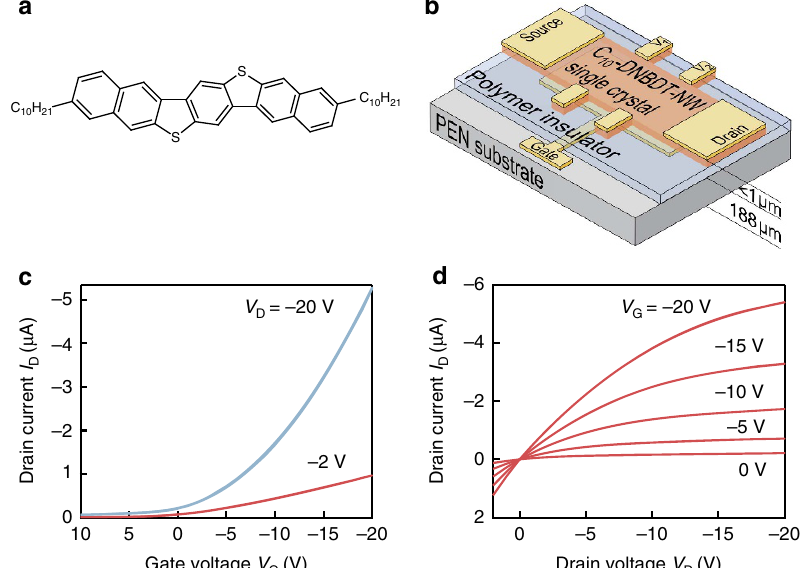
Figure 1 | Experimental set-up. ( a ) Molecular structure of C 10 -DNBDT-NW. ( b ) Schematic of the bottom-gate top-contact organic field-effect transistor structure with the voltage probes for the four-terminal measurement. ( c , d ) Transfer and output curves for device A before applying